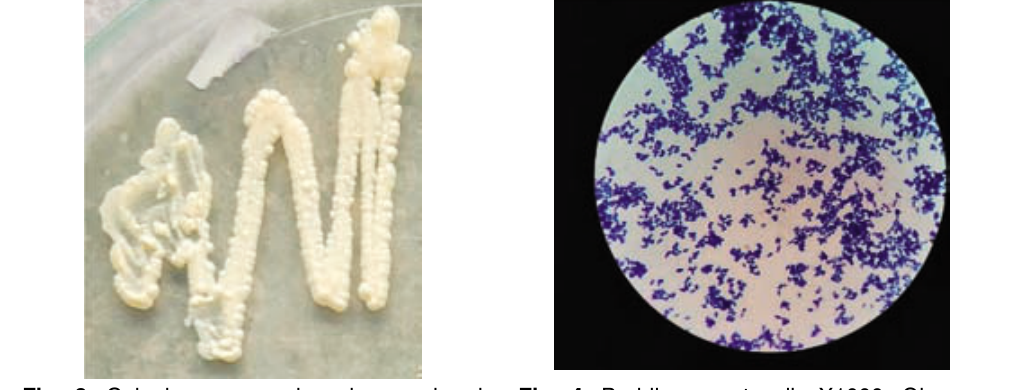
Fig. 3. Colonies appeared as ivory colored convex structure s